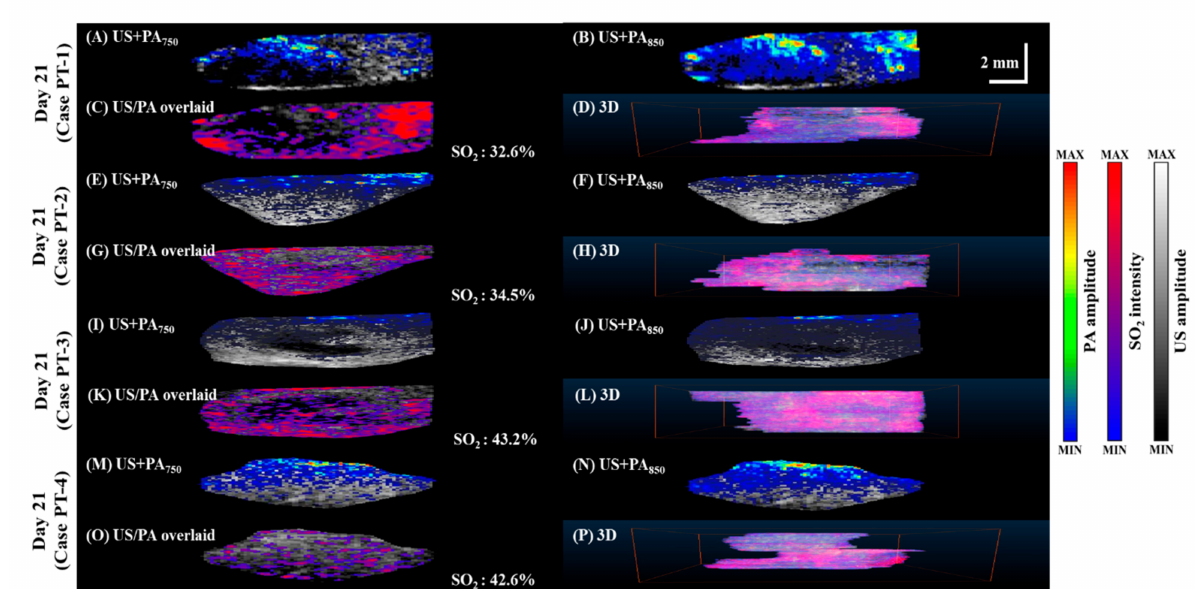
Figure 7. Relative SO 2 levels in pancreatic tumor in mice imaged 21 days after tumor cell injection. ( A , E , I , M ) PA images acquired at 750 nm overlaid with grayscale US B-mode images. ( B , F , J , N ) PA images acquired at 850 nm overlaid with grayscale US B-mode images. ( C , G , K , O ) SO 2 was calculated as the percentage of oxygenated hemoglobin relative to total hemoglobin based on dual-wavelength PA imaging at 750 and 850 nm and overlaid with grayscale US B-scan images. ( D , H , L , P ) C-scan of SO 2 dynamics. Rotational 3D images can be seen in Supplementary Materials Video